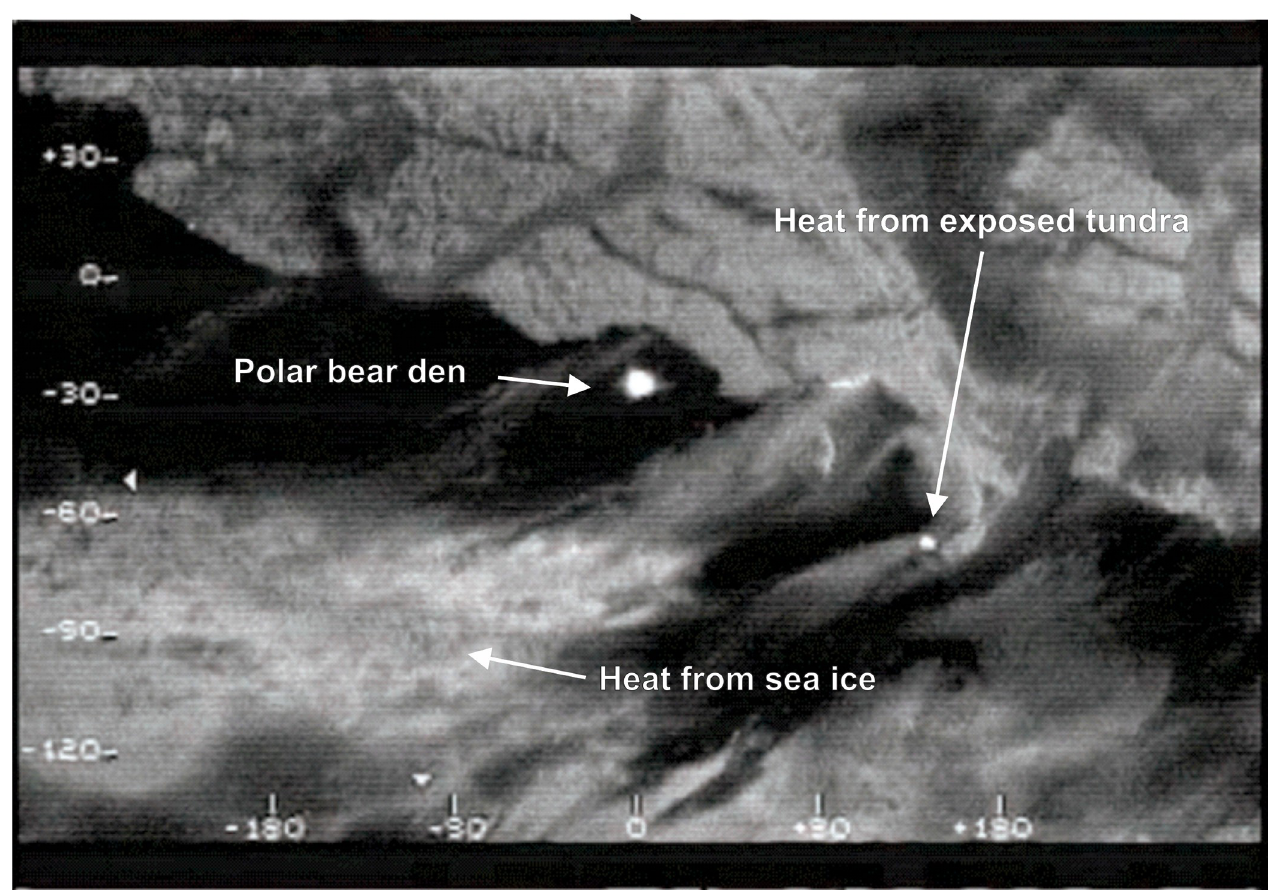
Fig 2. Forward-looking infrared image of two polar bear dens in the snow bank on the south shore of an Alaskan coastal island. Also note hotspots created by exposed tundra and warmth radiating up from sea ice with a thin covering of snow.